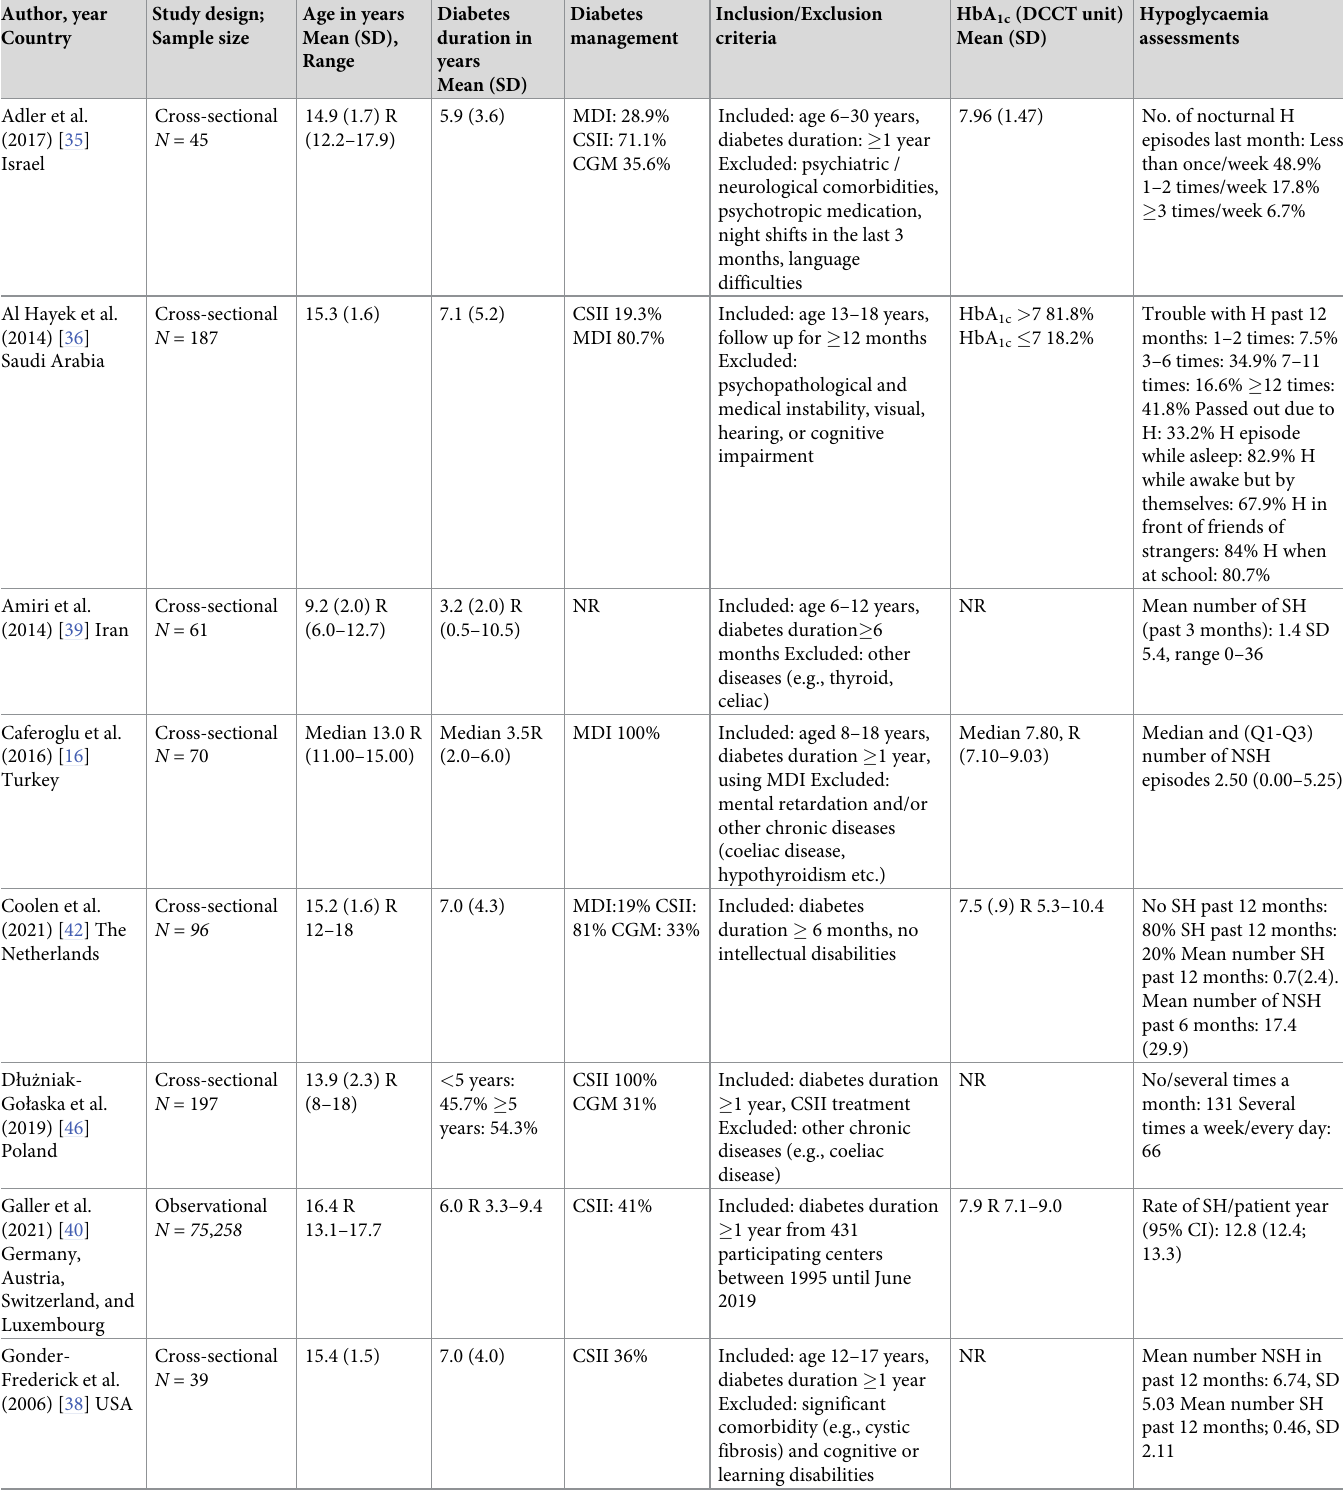
Table 2. Sociodemographic and clinical information and inclusion and exclusion criteria of the included